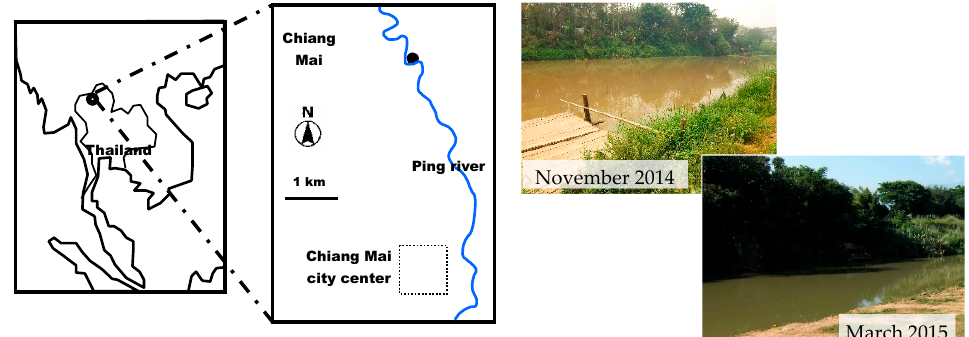
Figure 1. Location of the Ping River in Chiang Mai, Thailand.